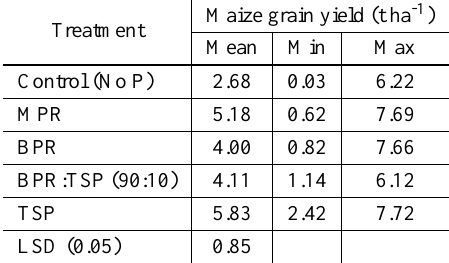
Mean maize grain yields for various P treatments in western Kenya during the 2000 long rains season at 26